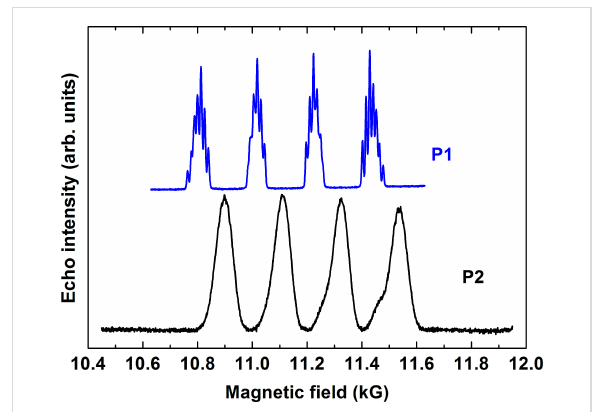
Figure 5: Echo detected ESR spectra of P1 (top) and P2 (bottom) at a frequency ν = 33.899 GHz (P1) and 33.915 GHz (P2) (Q-band) and at T = 20 K for the magnetic field oriented normal (90°) to the molecular plane. The difference of the line positions of the two spectra is due to the different g -factor of Cu for the studied samples g z (P1) = 2.184 [9] and g z (P2) = 2.159 [10].